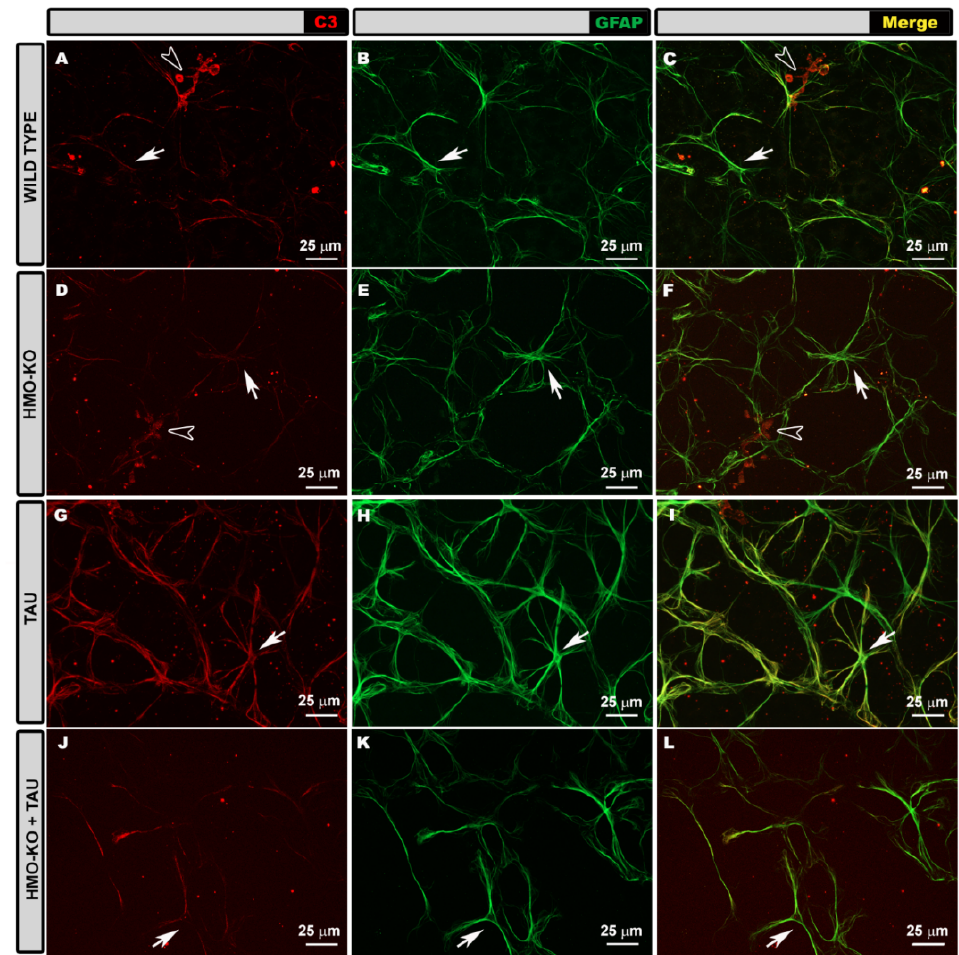
Figure 11. Retinal wholemount. Double immunohistochemical staining with GFAP (green) and C3 (red) in the different study groups: WT ( A – C ), HMO-KO ( D – F ), TAU ( G – I ), HMO-KO+TAU ( J – L ); 40 × magnification. Arrows point to astrocytes; hollow arrowheads point to macrophages. Number of retinas used in the experiment: WT n = 6, HMO-KO n = 6, TAU n = 6, and HMO-KO+TAU n = 6.